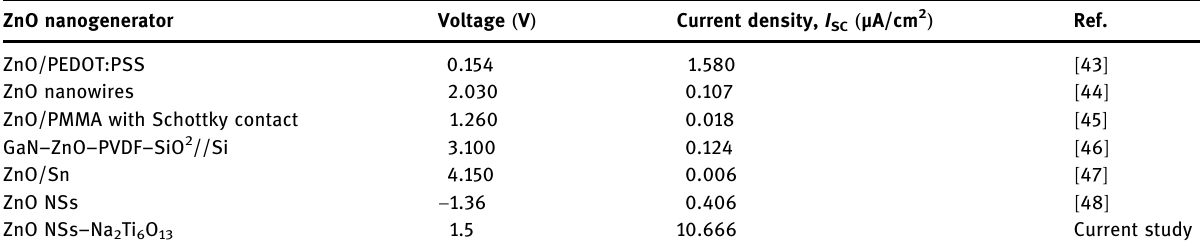
Table 1: Voltage and current measurements of ZnO NPs – NTO compared with several other studies ZnO nanogenerator